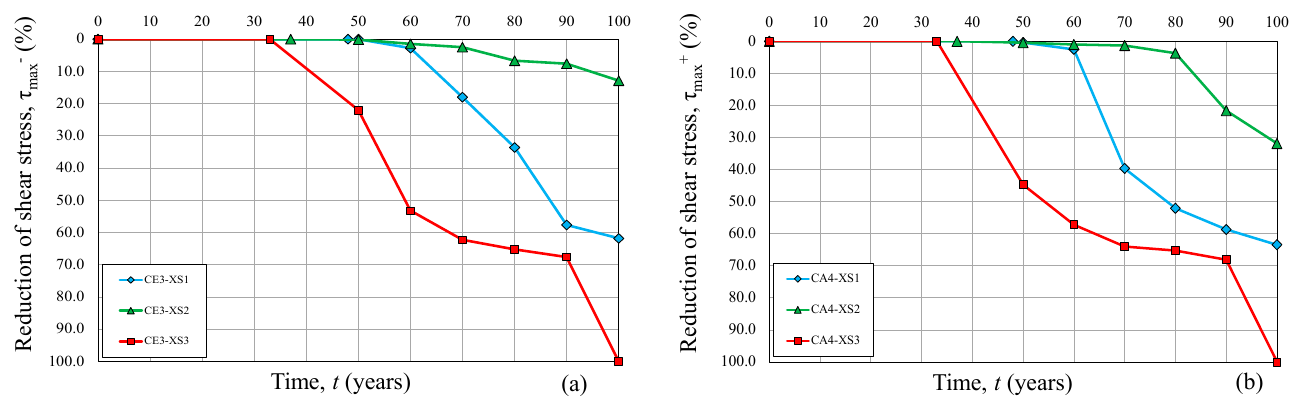
Figure 7. Maximum shear stress, τ max , percentage reduction over time for different exposure classes: ( a ) panel CE3 and ( b ) panel CA4.